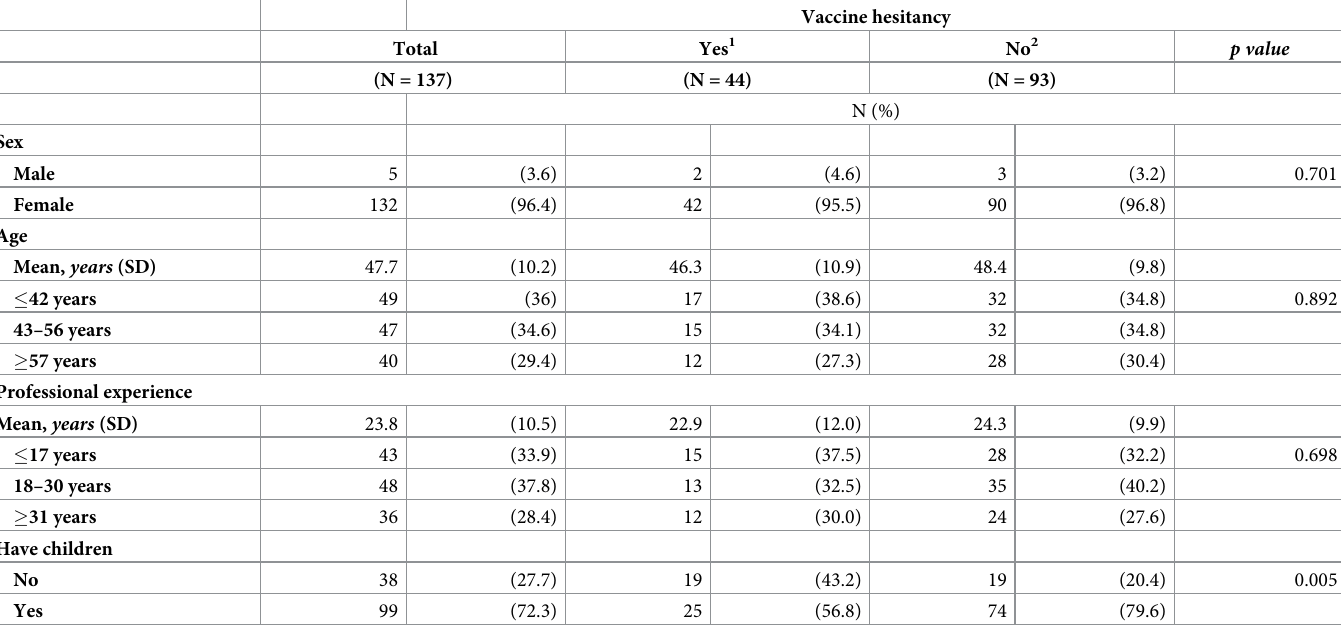
Table 1. Characteristics of the paediatric nursing population stratified by vaccine hesitancy. Barcelona. 2016–17.